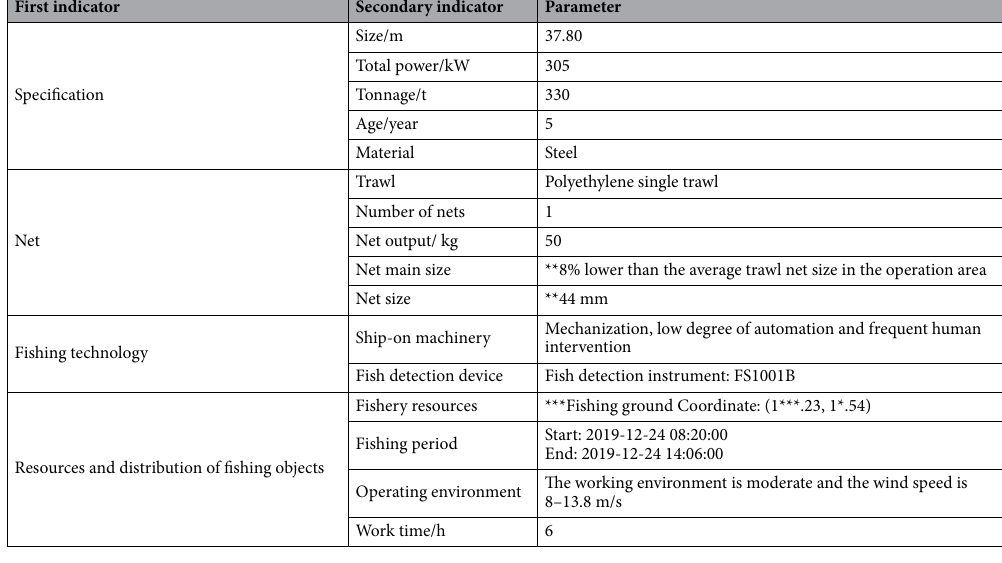
Resources and distribution of fishing